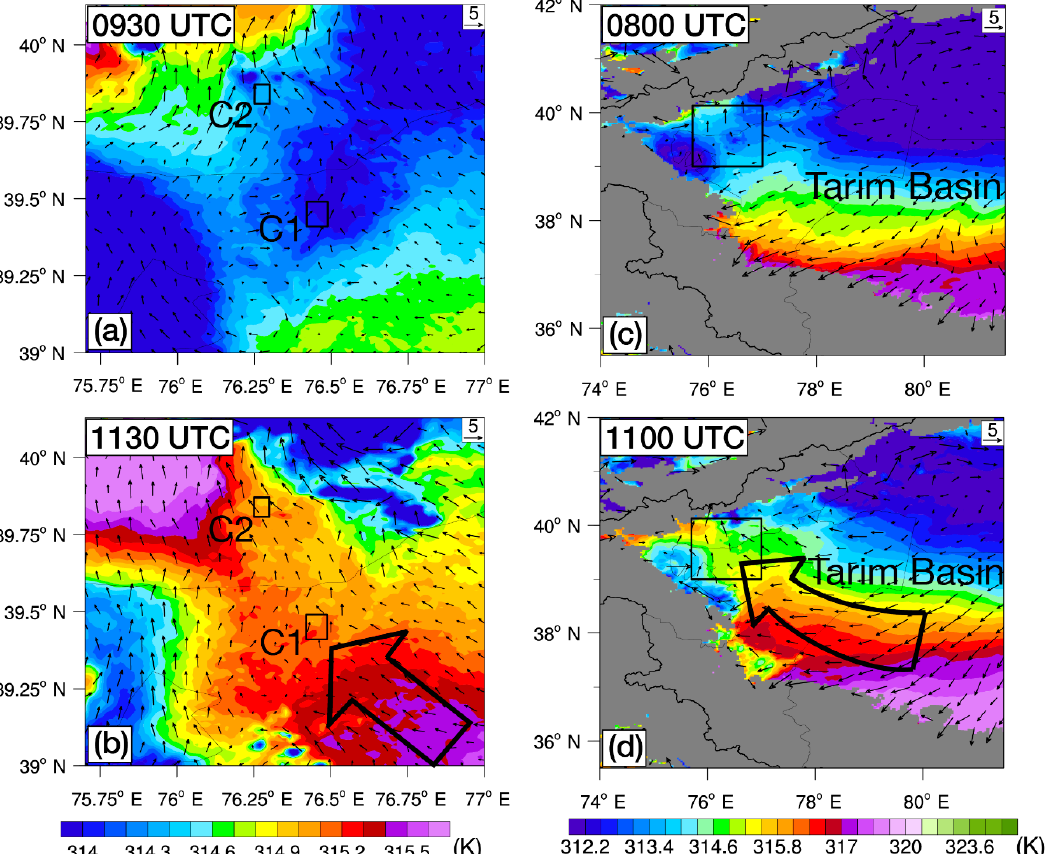
Figure 16. ( a , b ) Potential temperature (shading, unit: K) and wind field (arrows, unit: m s − 1 ) at 3000 m ASL on 23 June 2015. The small boxes denote the area where the C1 and C2 occurred, the black hollow arrow indicates the warm advection from the southeast. ( c , d ) are the same as ( a , b ) but for a bigger scope at different times, the box shows the area shown in the left panels. The gray areas indicate the topography. The specific time is shown in the upper left corner of each panel.